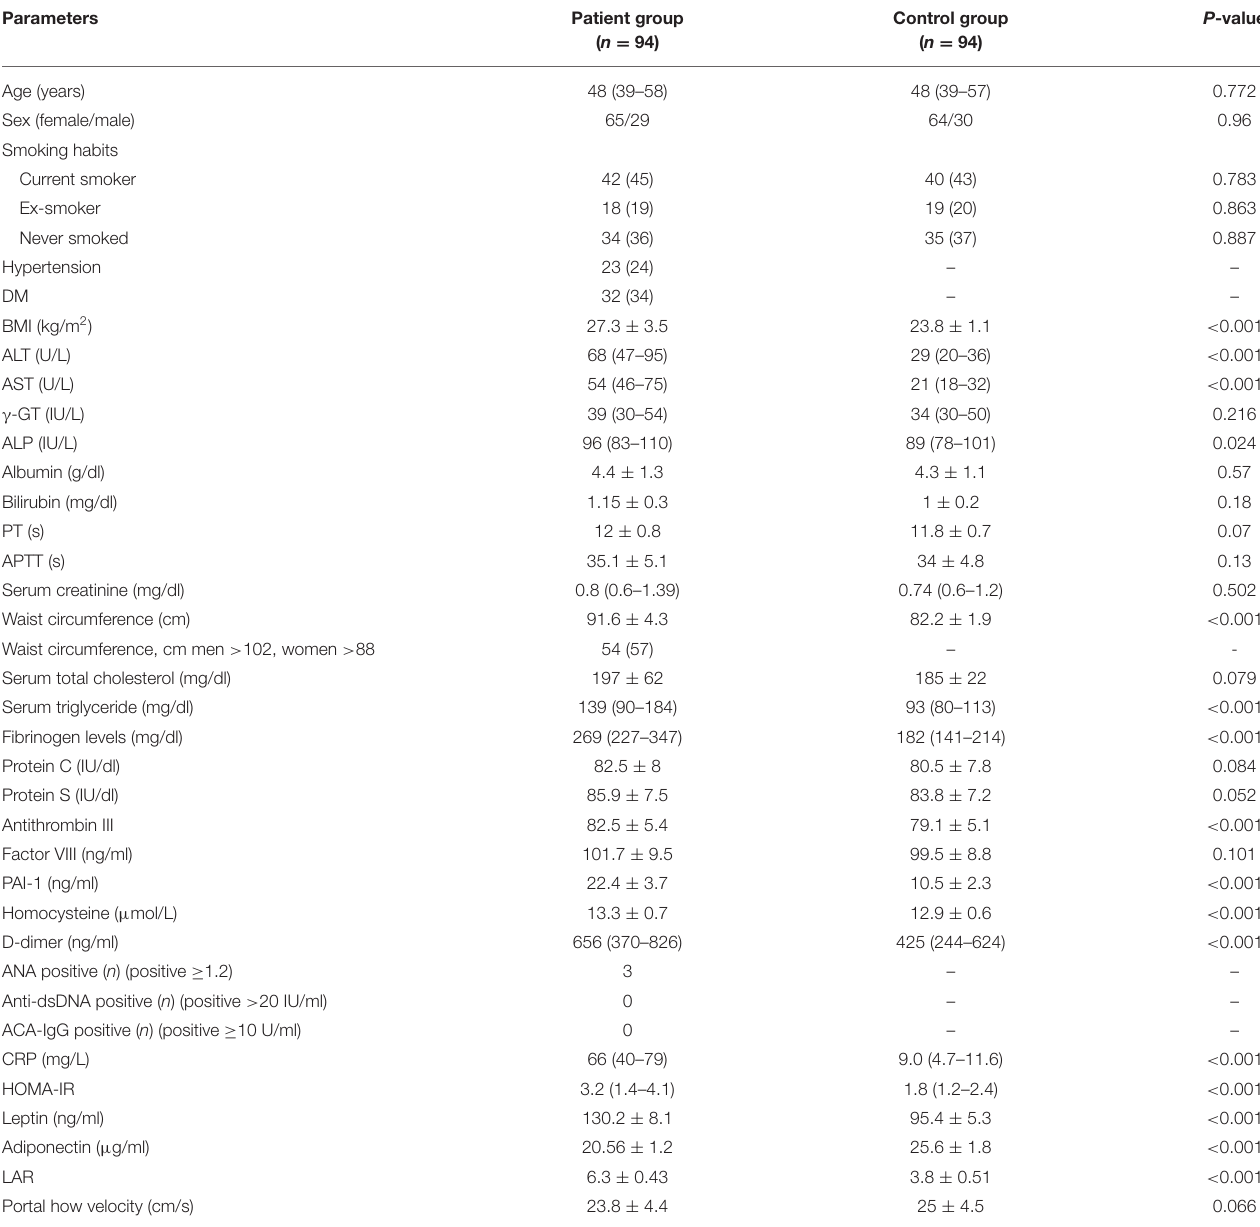
TABLE 1 | Biochemical, clinical, and demographic characteristics of enrolled patients and control group at the baseline of the study.